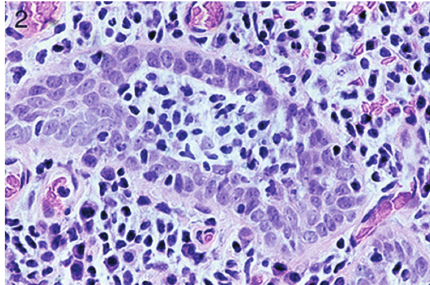
Figure 2: The microscopic feature of the second cases (haema- toxylin and eosin staining). Case 2: focal lymphoepithelial lesions in area of cystitis glandularis (hematoxylin-eosin, original magnifica- tion × 400). Reproduced from [4] with permission of the Editor-in- Chief of Archives of Pathology and Laboratory Medicine on behalf of the editorial team of the journal and the American Association of